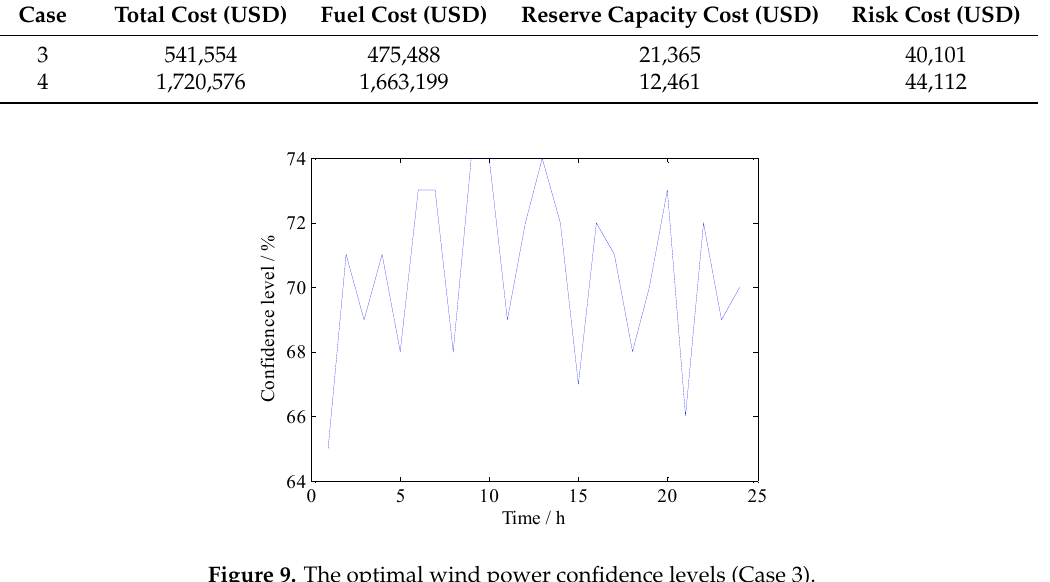
Figure 9. The optimal wind power confidence levels (Case 3).